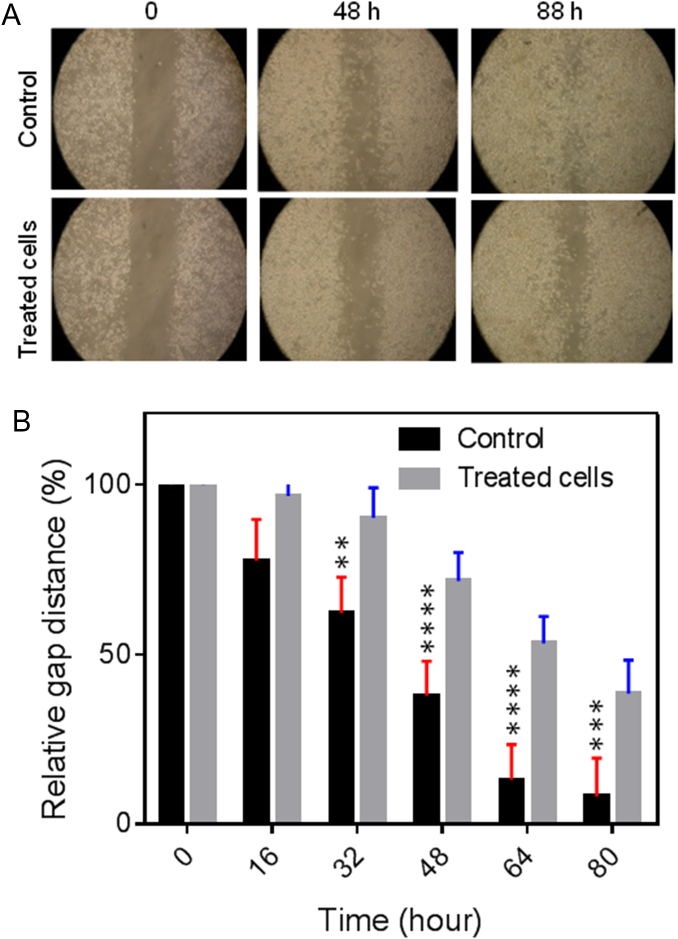
(A) The photograph of a wound healing assay performed on SKBR3 cells. The cell migration images tracked immediately after treatment t = 0 and every 8 h thereafter. (B) The relative change of gap distance with time for SKBR3 cells as a measure of cell migration. Mean values are shown ± SD of three independent experiments.